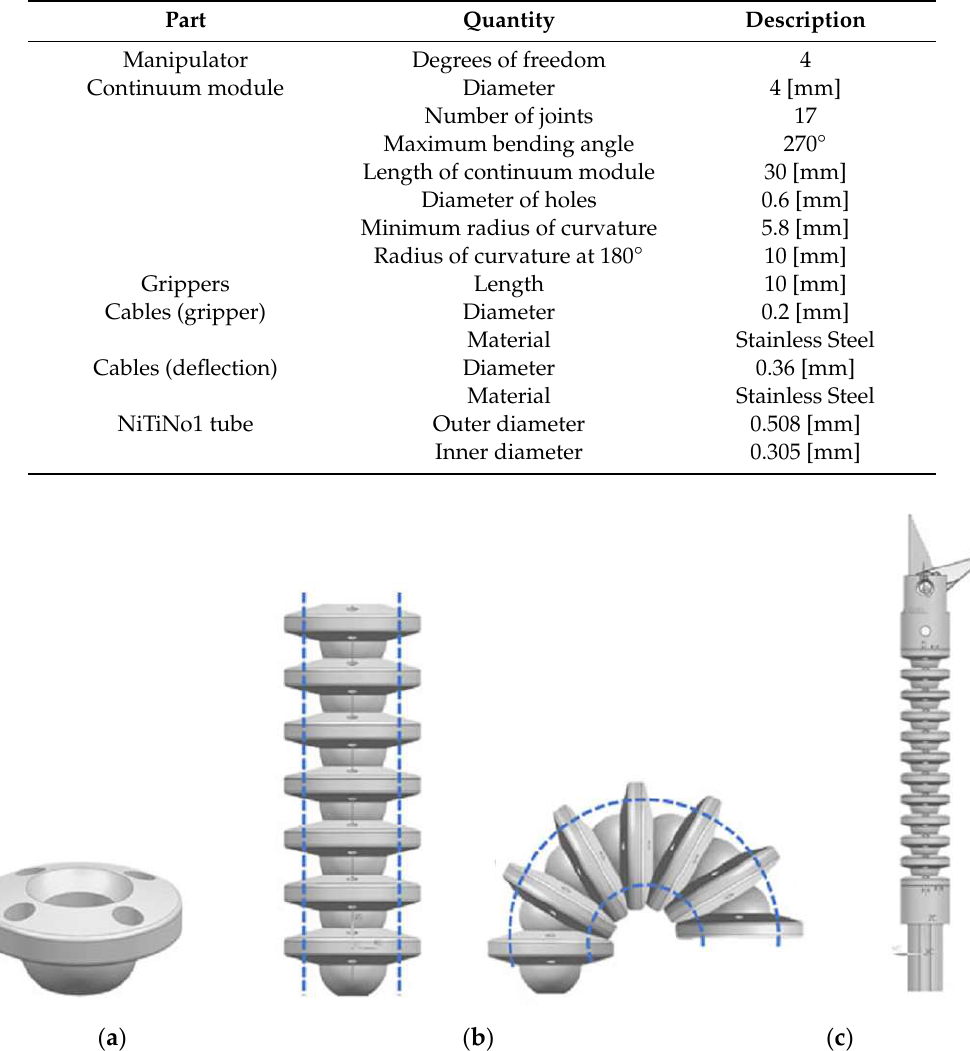
Figure 3. Continuum module of a surgical robot for the sinus: ( a ) continuum joint, ( b ) motion schematic, and ( c ) structure.